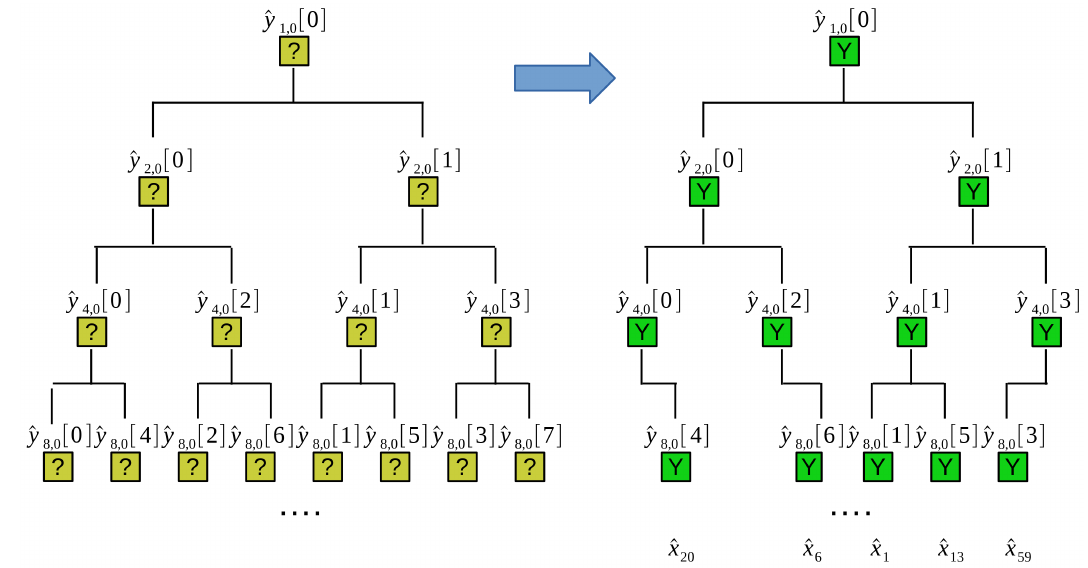
Figure 6. Example of the iterative framework based on the binary tree search method. The number of the efficient nodes of the first, second, third, and fourth layers of the binary tree is equal to one, two, four, and five,